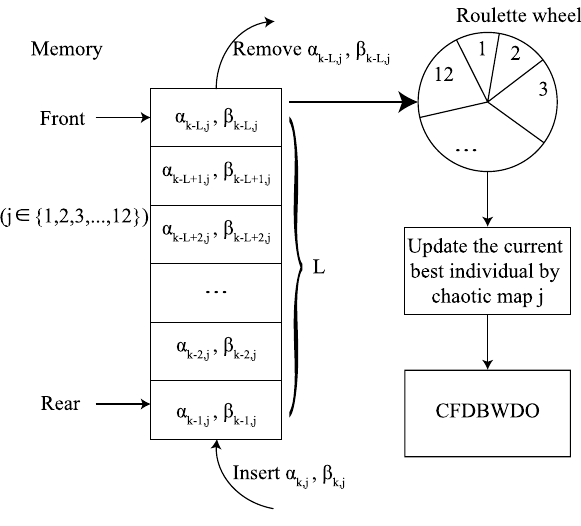
Fig. 1 CLS with selecting chaotic map based on